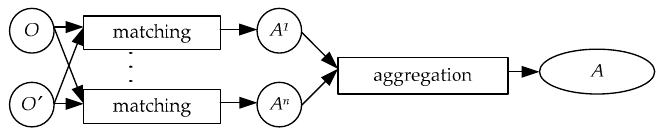
Figure 1. Parallel composition of basic matchers and the aggregation of the obtained matching results.